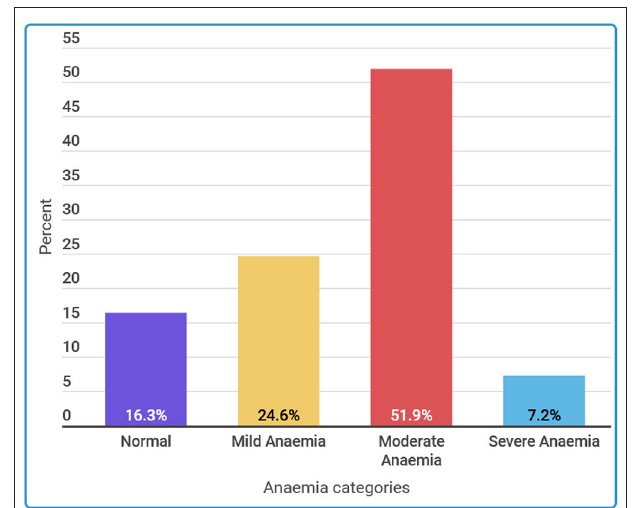
FIGURE 2 | Prevalence of anemia among pregnant